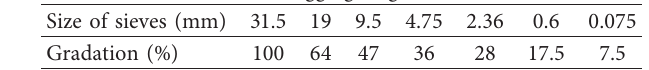
Table 3: Aggregate gradation.